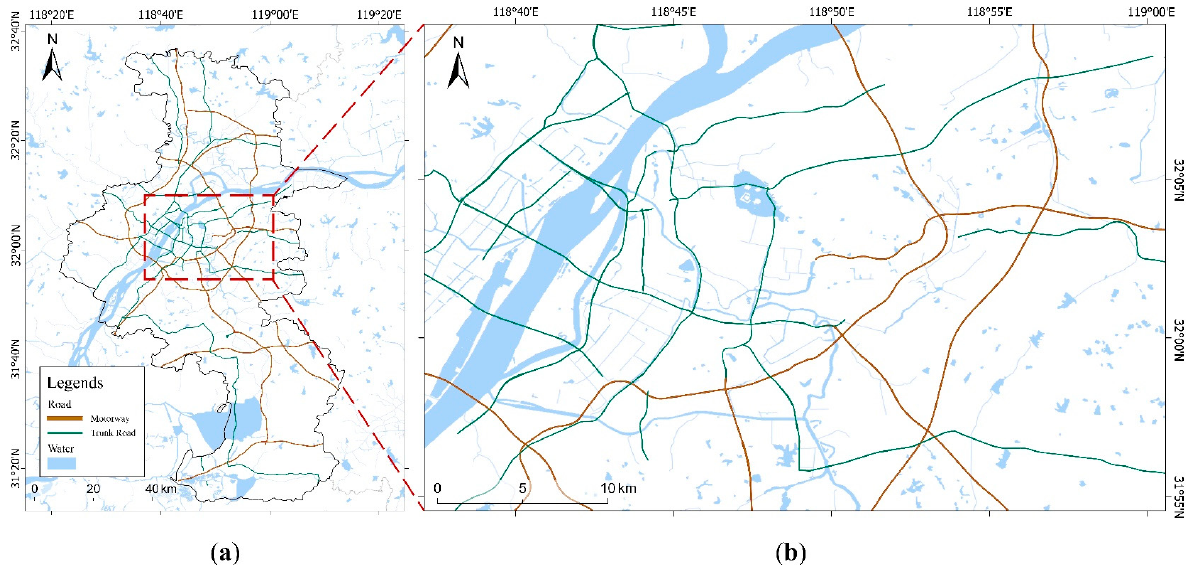
Figure 3. The study area of this experiment. ( a ) High-grade roads in Nanjing City, ( b ) a detailed display of roads in the middle of the city.